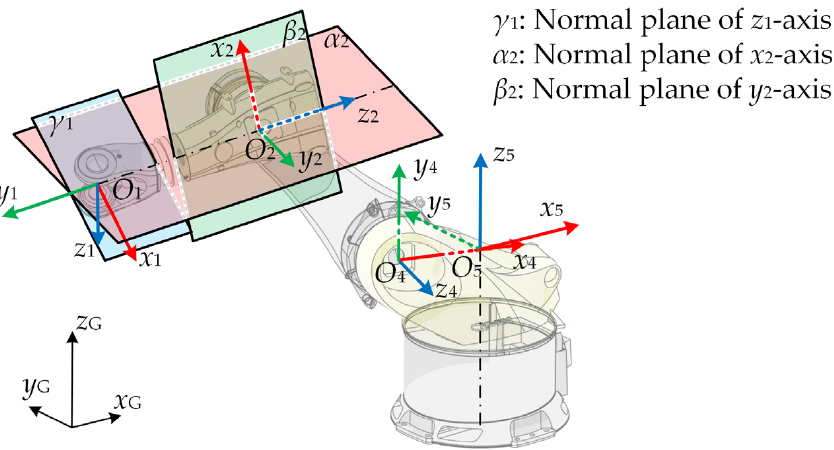
Figure 3. The calculation model of joint angle θ 2 .